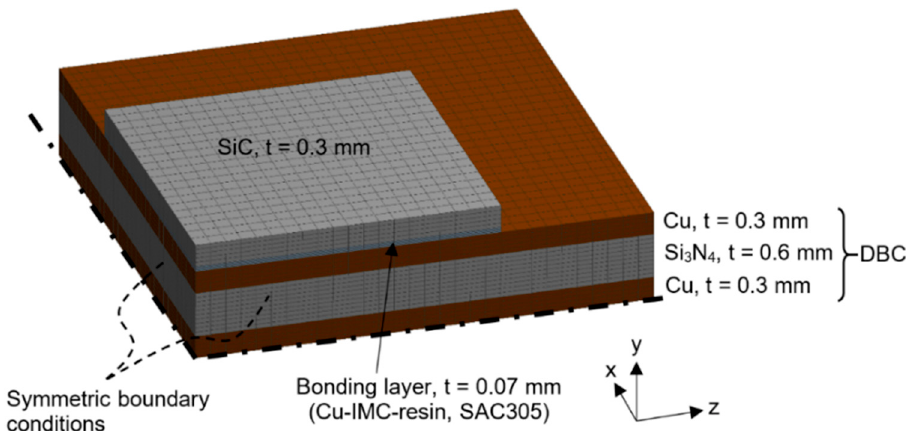
Figure 4. Silicon carbide-direct bonded copper (SiC-DBC) FE model for temperature cycling simulations. The sizes of the SiC chip and DBC substrate are 8 × 8 mm, and 12 × 12 mm, respectively.